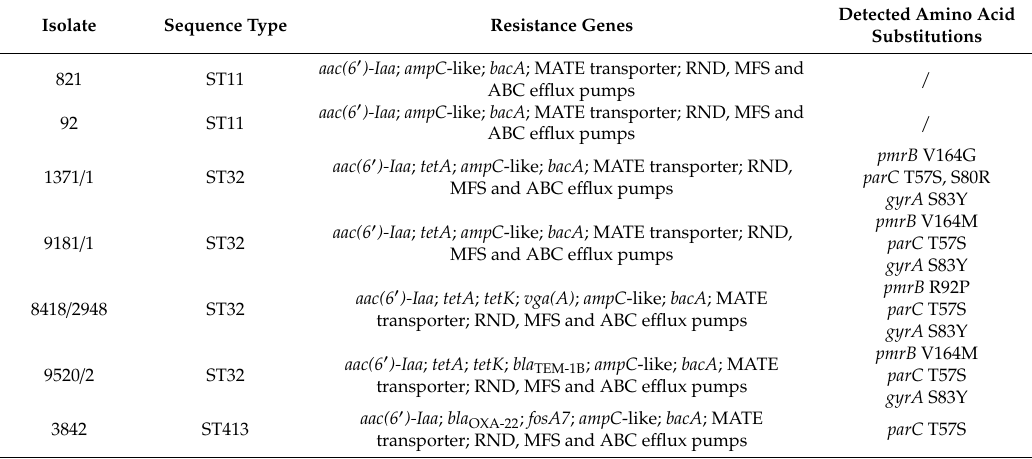
Table 2. Resistome of colistin-resistant S. Infantis isolates from Serbian poultry